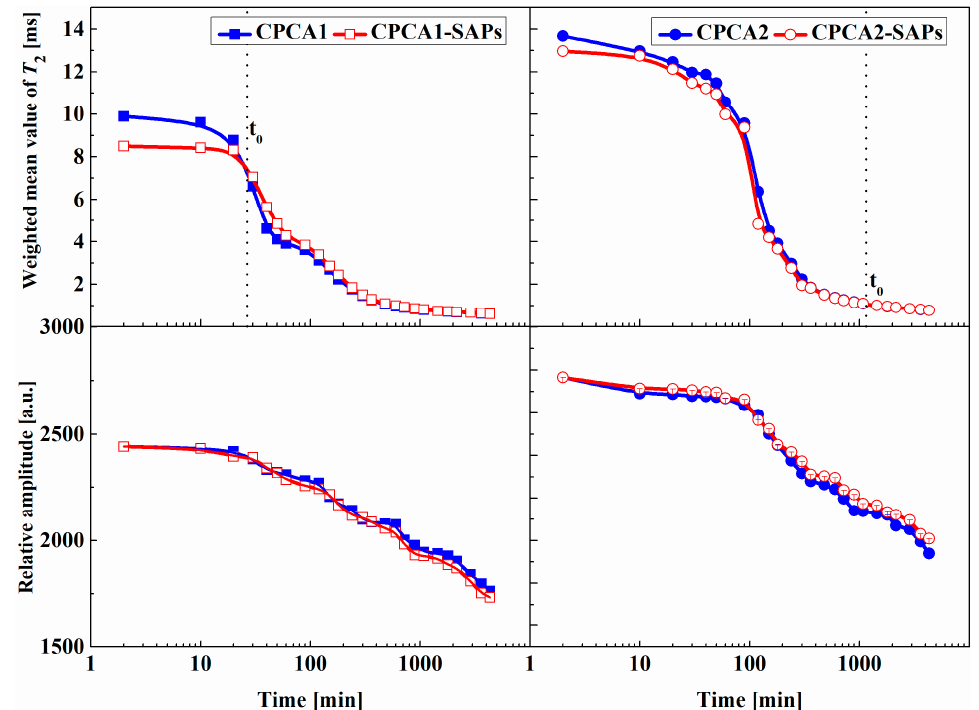
Figure 6. Evolution of weighted mean value of T 2 and relative amplitude of the samples from a hydration time of 2 min to 4430 min.